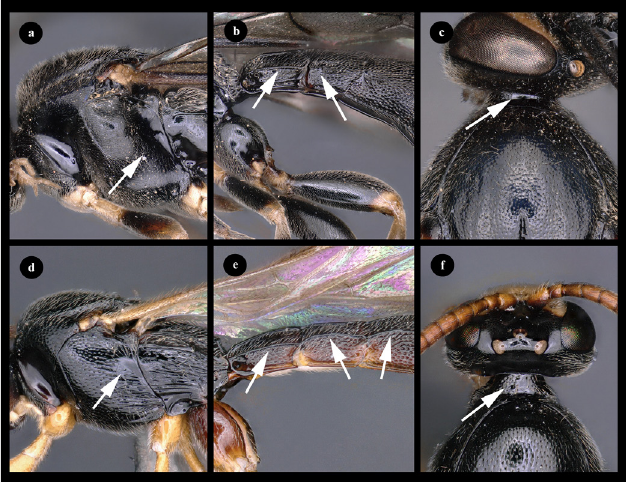
Fig. 4. a–c . Chorinaeus sp. a . Mesosoma, lateral view. b . Anterior metasomal tergites, lateral view. c . Mesosoma, dorsal view. d–f . Trieces isolatus Ranjith & Priyadarsanan, 2022. d . Mesosoma, lateral view. e . Anterior metasomal tergites, lateral view. f . Mesosoma, dorsal view. Arrow in Fig. 4a points to the presence of sulcus on mesopleuron (compared to the absence of sulcus on mesopleuron in Fig. 4d). Arrow in Fig. 4b points to metasomal tergites 2–3 without lateral carina (compared to metasomal tergites 1–3 with lateral carina in Fig. 4e). Arrow in Fig. 4c points to pronotum with dorsal transverse depression (compared to pronotum without dorsal transverse depression in Fig.